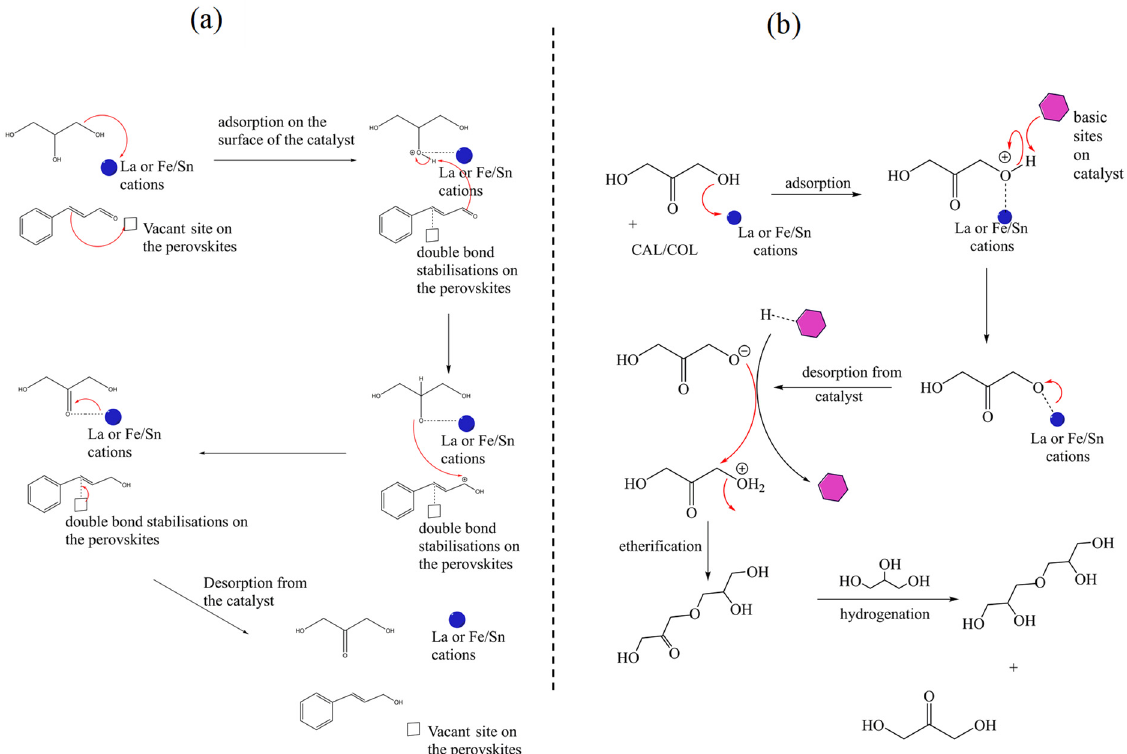
Scheme 3. Proposed mechanism showing glycerol transformations during ( a ) the formation of cinnamyl alcohol from cinnamaldehyde and ( b ) the formation of diglycerol .